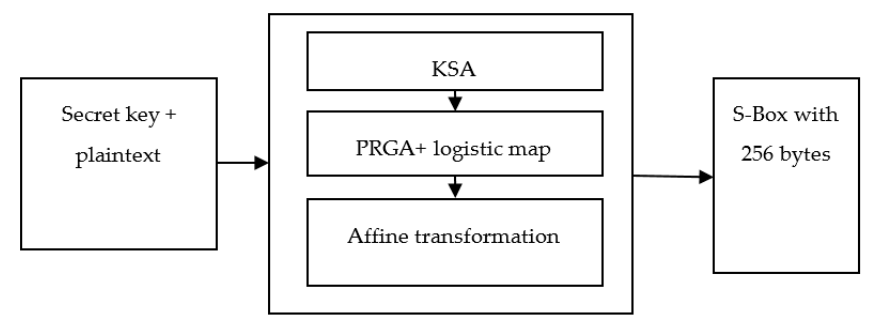
Figure 4. S-BOX using KSA and PRGA enforced by Logistic Chaotic Maps (LCM).